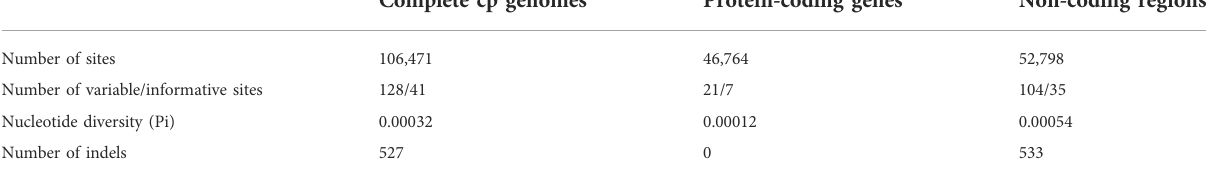
TABLE 3 Genetic diversity of T. mongolica